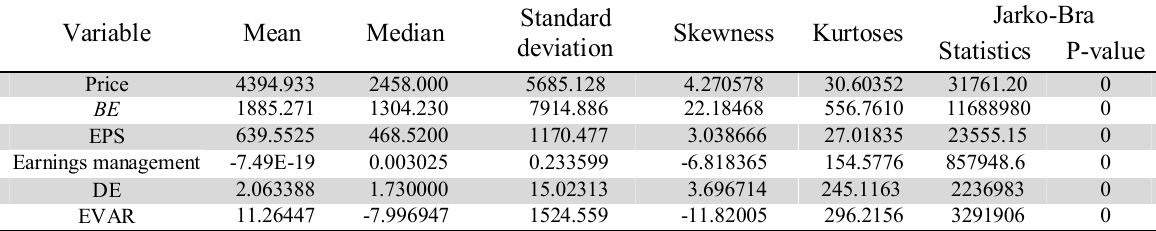
The summary of basic